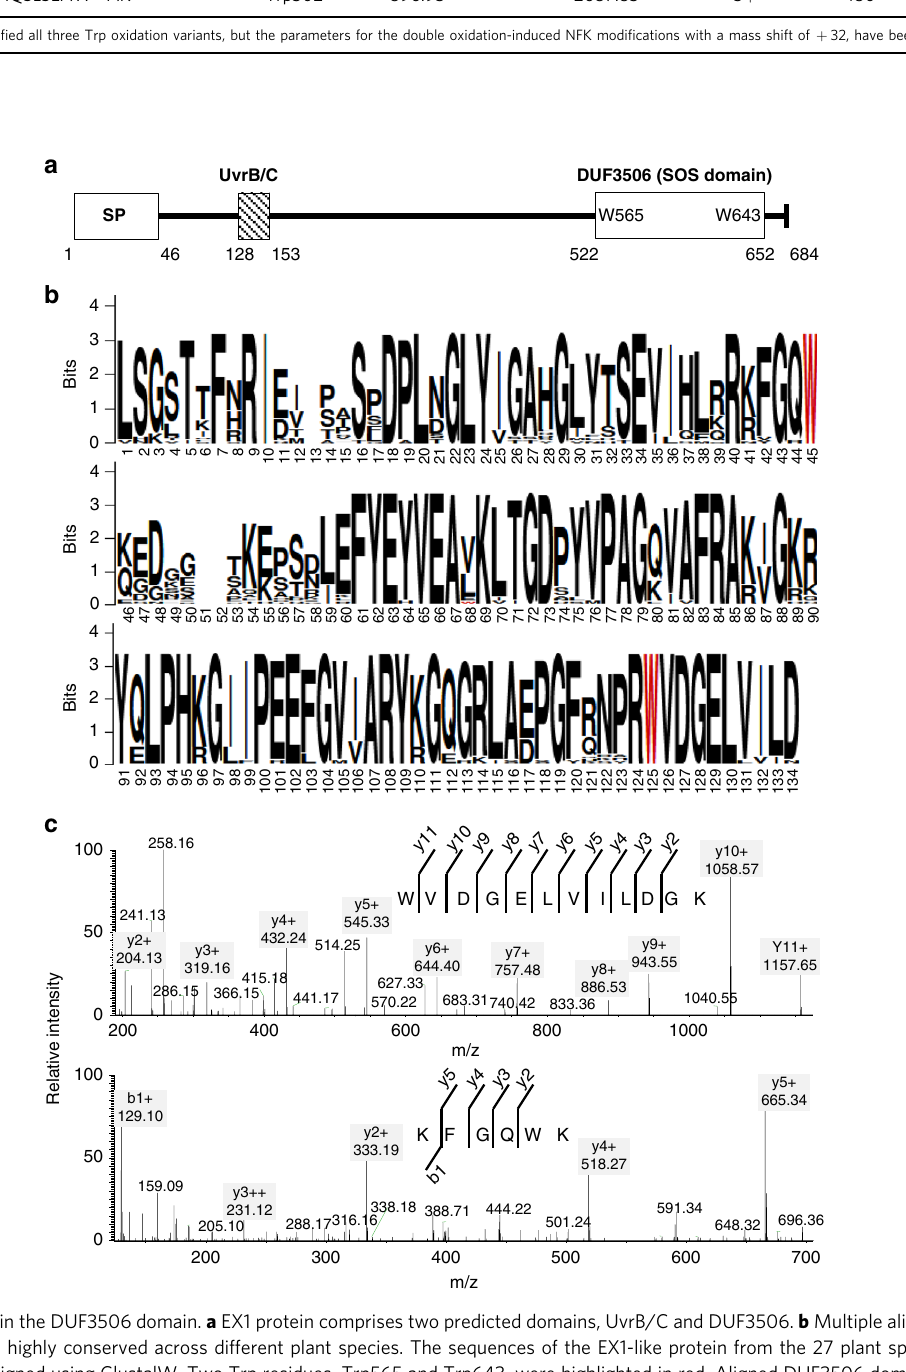
MS-based PTM analysis identi fi ed all three Trp oxidation variants, but the parameters for the double oxidation-induced NFK modi fi cations with a mass shift of + 32, have been shown here